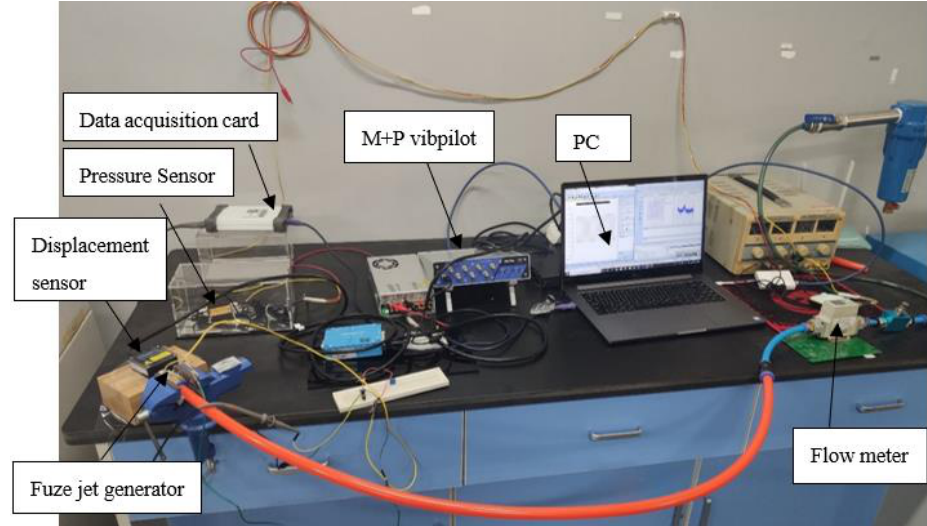
Figure 4. Blowing simulation test process.